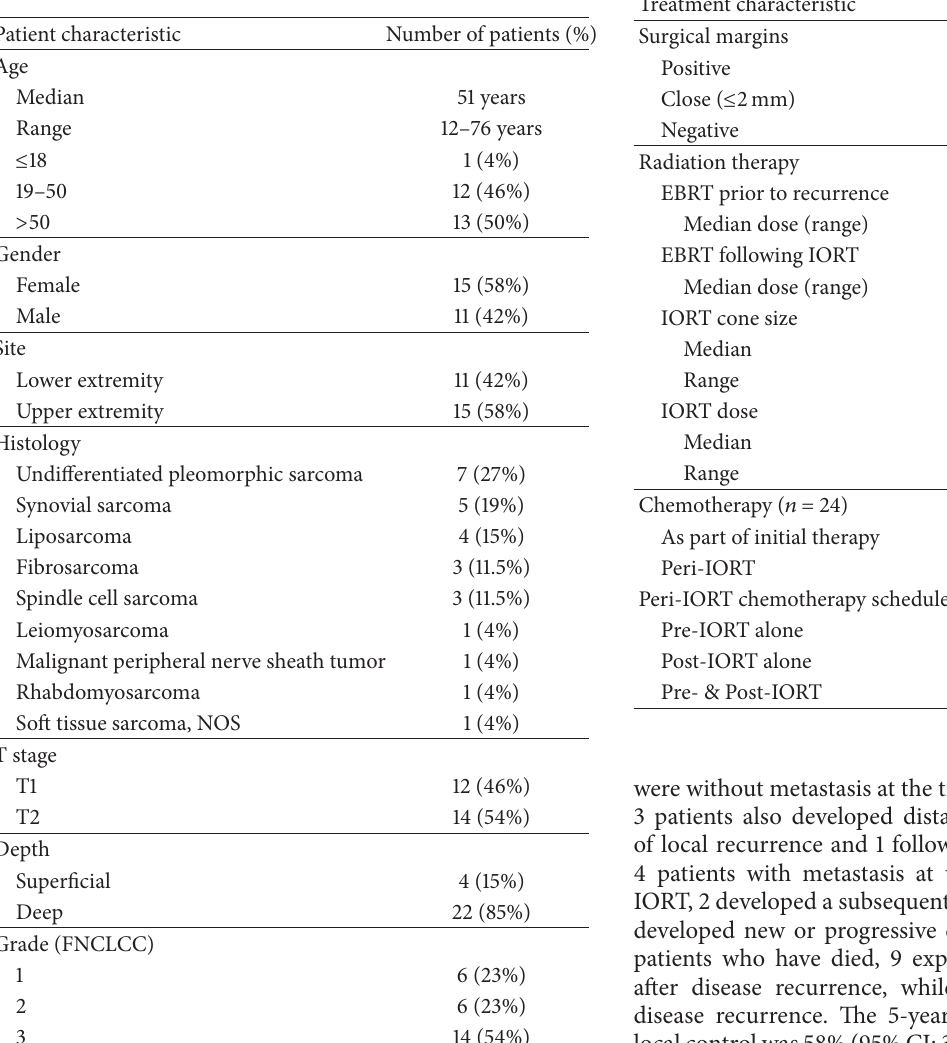
Table 1: Baseline patient characteristics at time of reresection and IORT ( 𝑛 = 26).